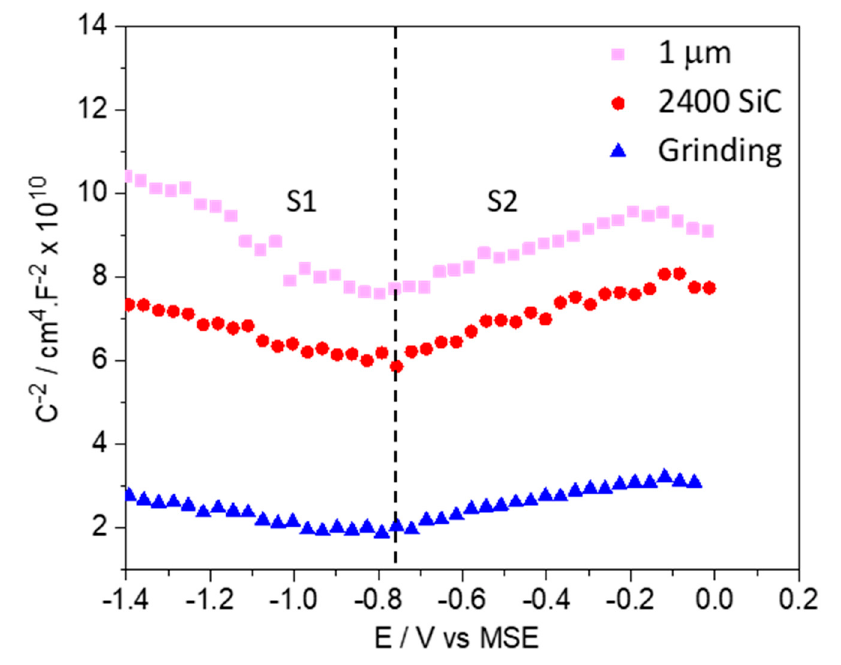
Figure 4. MS plots of C 2 − for the passive film, for 304L SS in borate buffer (pH = 9.2) for grinding process, polished samples down to 2400 with SiC, and 1 µm with diamond paste.